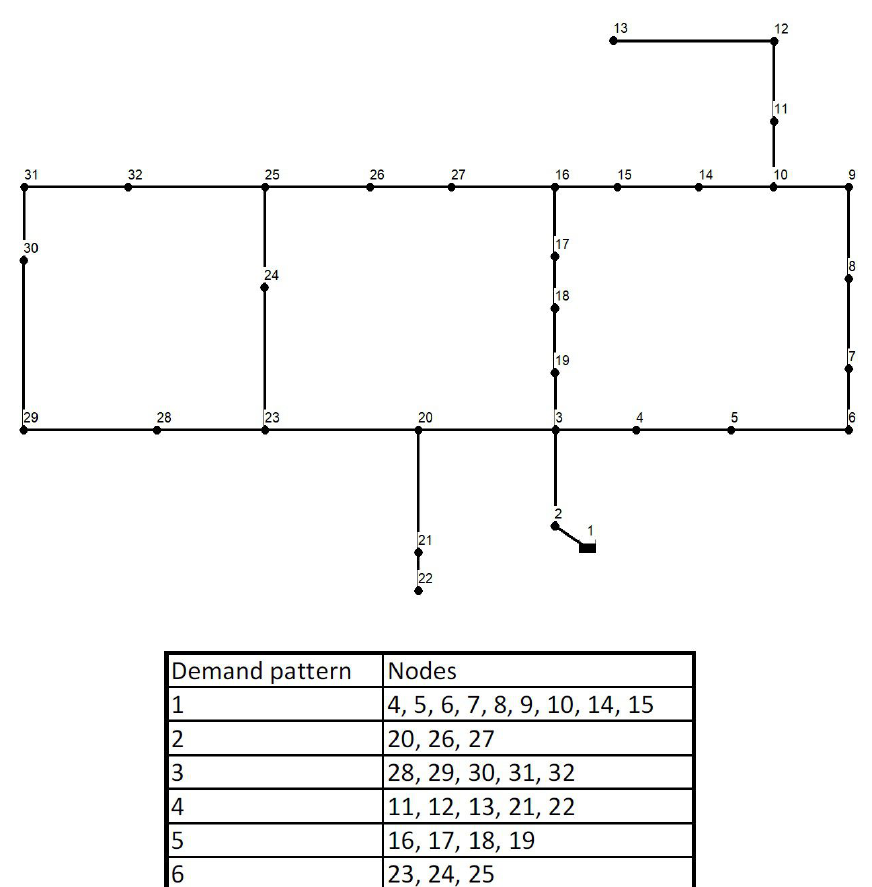
Figure 2. Hanoi network with pattern demands in